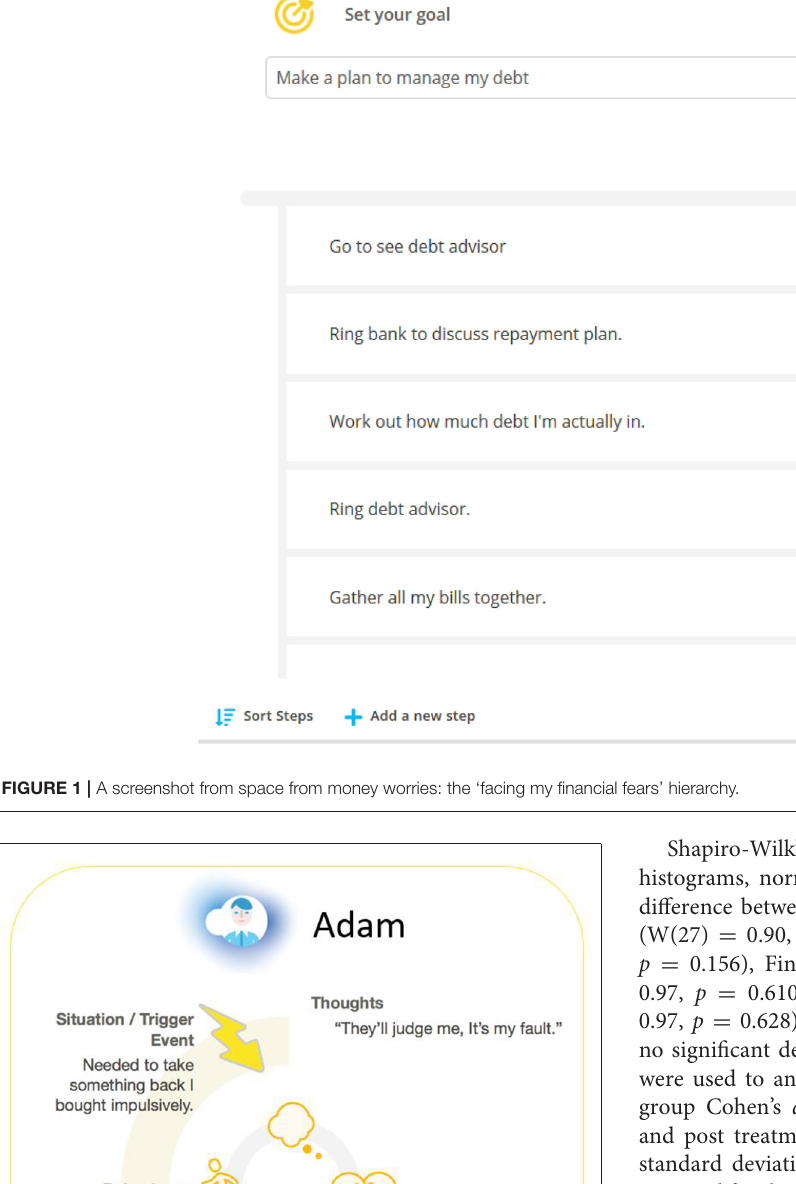
by chained equation via “MICE” package in R was employed, undertaking 100 iterations for the imputation process, the imputation method engaged predictive mean matching (pmm) for the missing data points in the quantitative